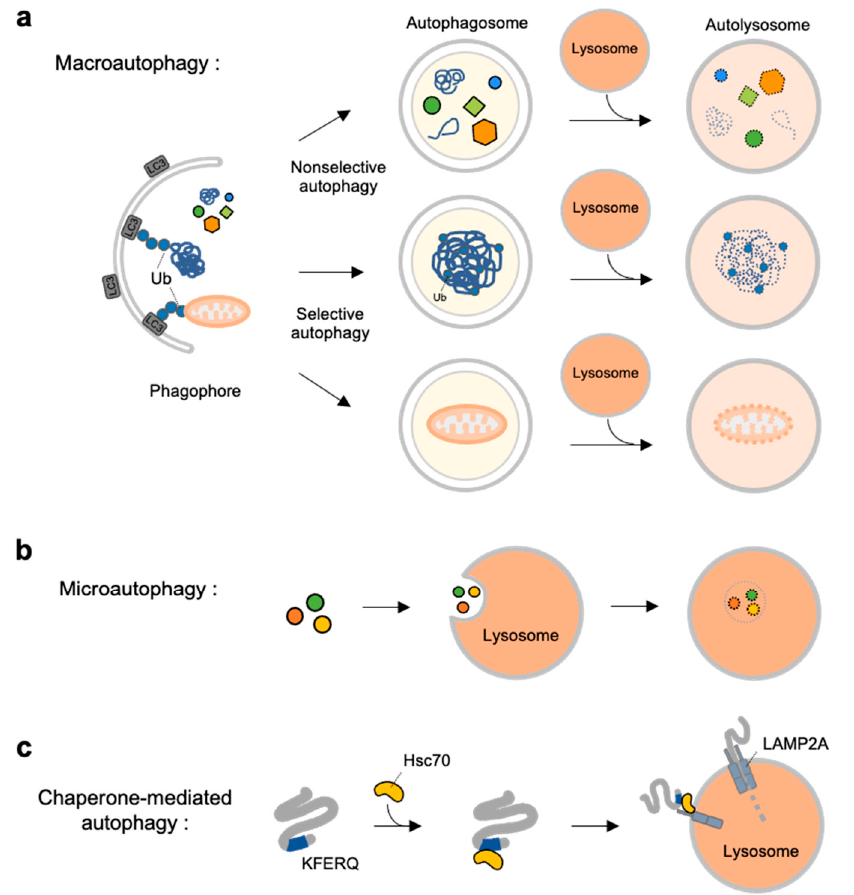
Figure 1. Overview of three types autophagy. ( a ) Macroautophagy is initiated by assembly of double-membrane called phagophore. Non-selective or selective cargoes are enclosed in autophagosomes. Autophagosomes fuse with lysosomes to become autolysosomes. The cargoes within autolysosome are digested by lysosomal enzymes. ( b ) In microautophagy, the cargoes directly engulfed by lysosomal membrane and degraded in the lysosome. ( c ) In chaperone-mediated autophagy (CMA), a selective subset of cytosolic proteins containing a KFERQ-motif is recognized by heat shock cognate protein of 70 kDa (Hsc70). They are delivered to lysosomal membrane by binding to lysosomal-associated membrane protein 2A (LAMP2A). The cargoes are unfolded and translocated inside the lysosome where they are degraded by lysosomal enzymes.